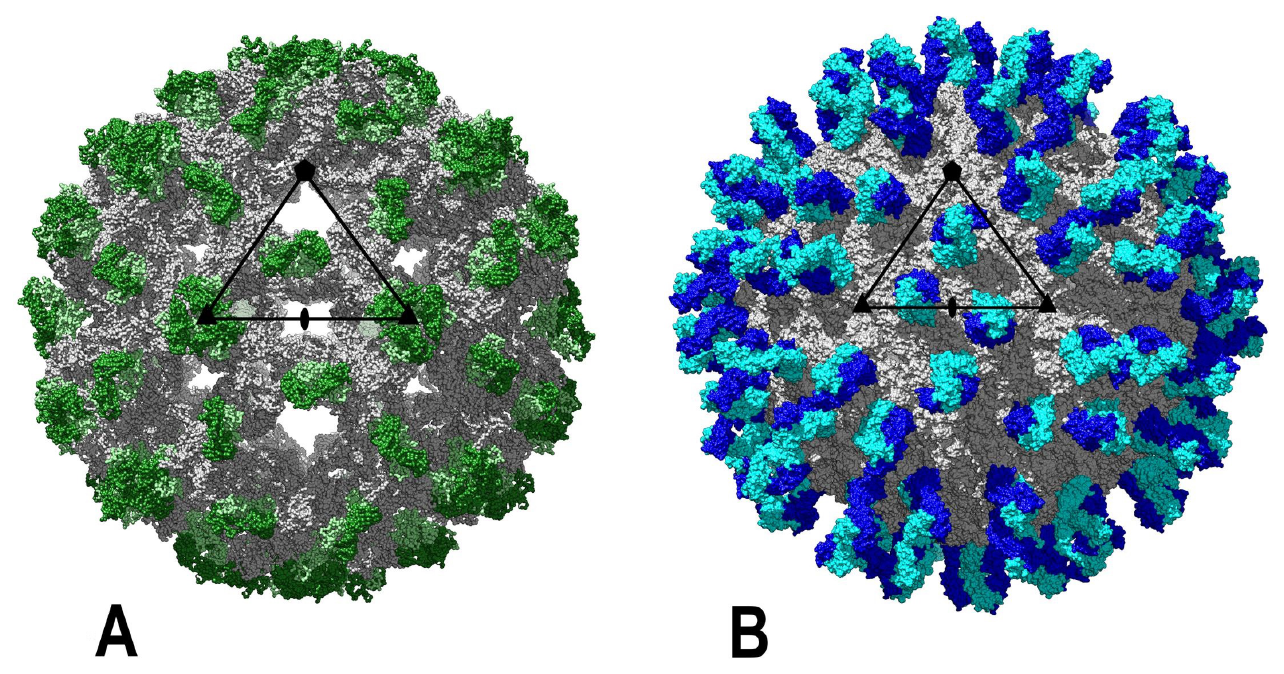
Figure 3. Models of some JE serocomplex flavivirus particles with bound Fabs. ( A ). Immature WNV particle with bound E53, which is cross-reactive and preferentially binds immature flavivirus particle but not the mature particles. The Fab chains are depicted in green and light green. ( B ). Mature WNV with bound CR4354, which binds two neighboring E molecules and neutralizes by blocking the conformational rearrangement essential for membrane fusion. Fab chains are shown in blue and light